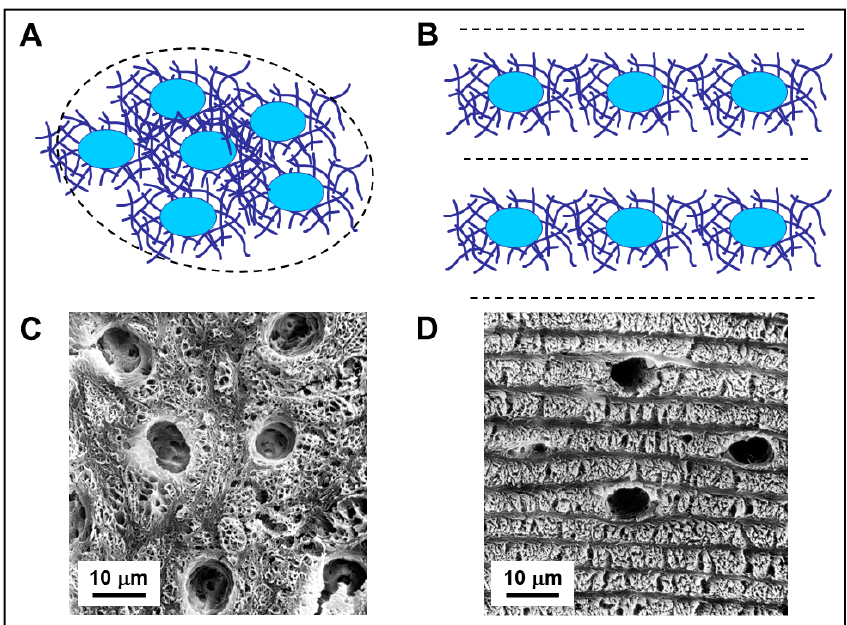
Figure 4. ( A , B ): Schematic drawing showing arrangement of osteocytes and the surrounding collagen fibers in not ‐ lamellar ‐ woven ‐ bone ( A ) and in lamellar ‐ woven ‐ bone ( B ). In both types of bone tissue, osteocyte lacunae (blue ovals) are surrounded by perilacunar matrices of loosely arranged collagen fibers. In lamellar ‐ woven ‐ bone, the loose lamellae result as a consequence of alignment and fusion of the perilacunar loose matrices of the osteocytes arranged in planes; the dense bundles of collagen fibers do not contain osteocytes. ( C , D ): SEM micrographs of not ‐ lamellar ‐ woven ‐ bone ( C ) and lamellar ‐ woven ‐ bone ( D ); the osteocyte lacunae are larger, more numerous, and irregularly distributed in not ‐ lamellar ‐ woven ‐ bone with respect to lamellar ‐ woven ‐ bone, where they are only located inside loose lamellae. Note that dense lamellae, alternating with the loose ones, are thinner and do not contain osteocyte lacunae.